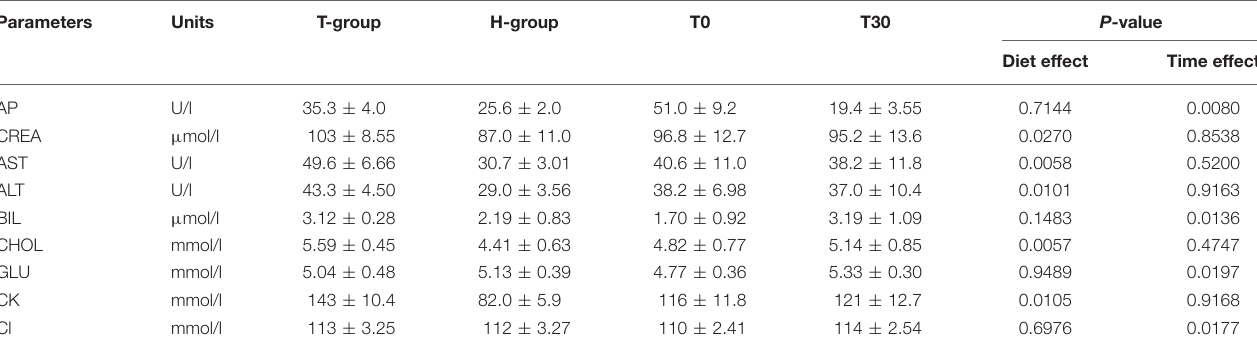
TABLE 4 | Main biochemical